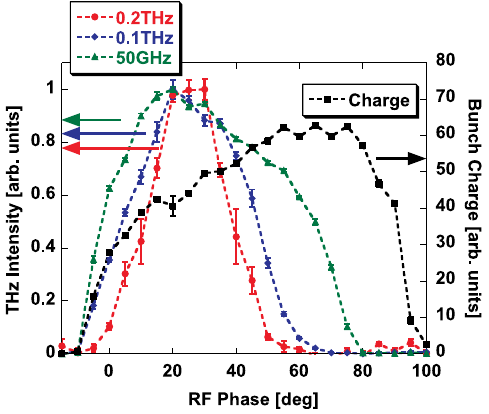
FIG. 16 (color online). CSR intensity as a function of the injection phase detected by 0.05 THz SBD (green), 0.1 THz SBD (blue), and 0.2 THz BPF þ SBD (red). Bunch charge is also plotted as a reference. The peak of THz intensity was around 20° and the profile became narrower as the radiation frequency grew